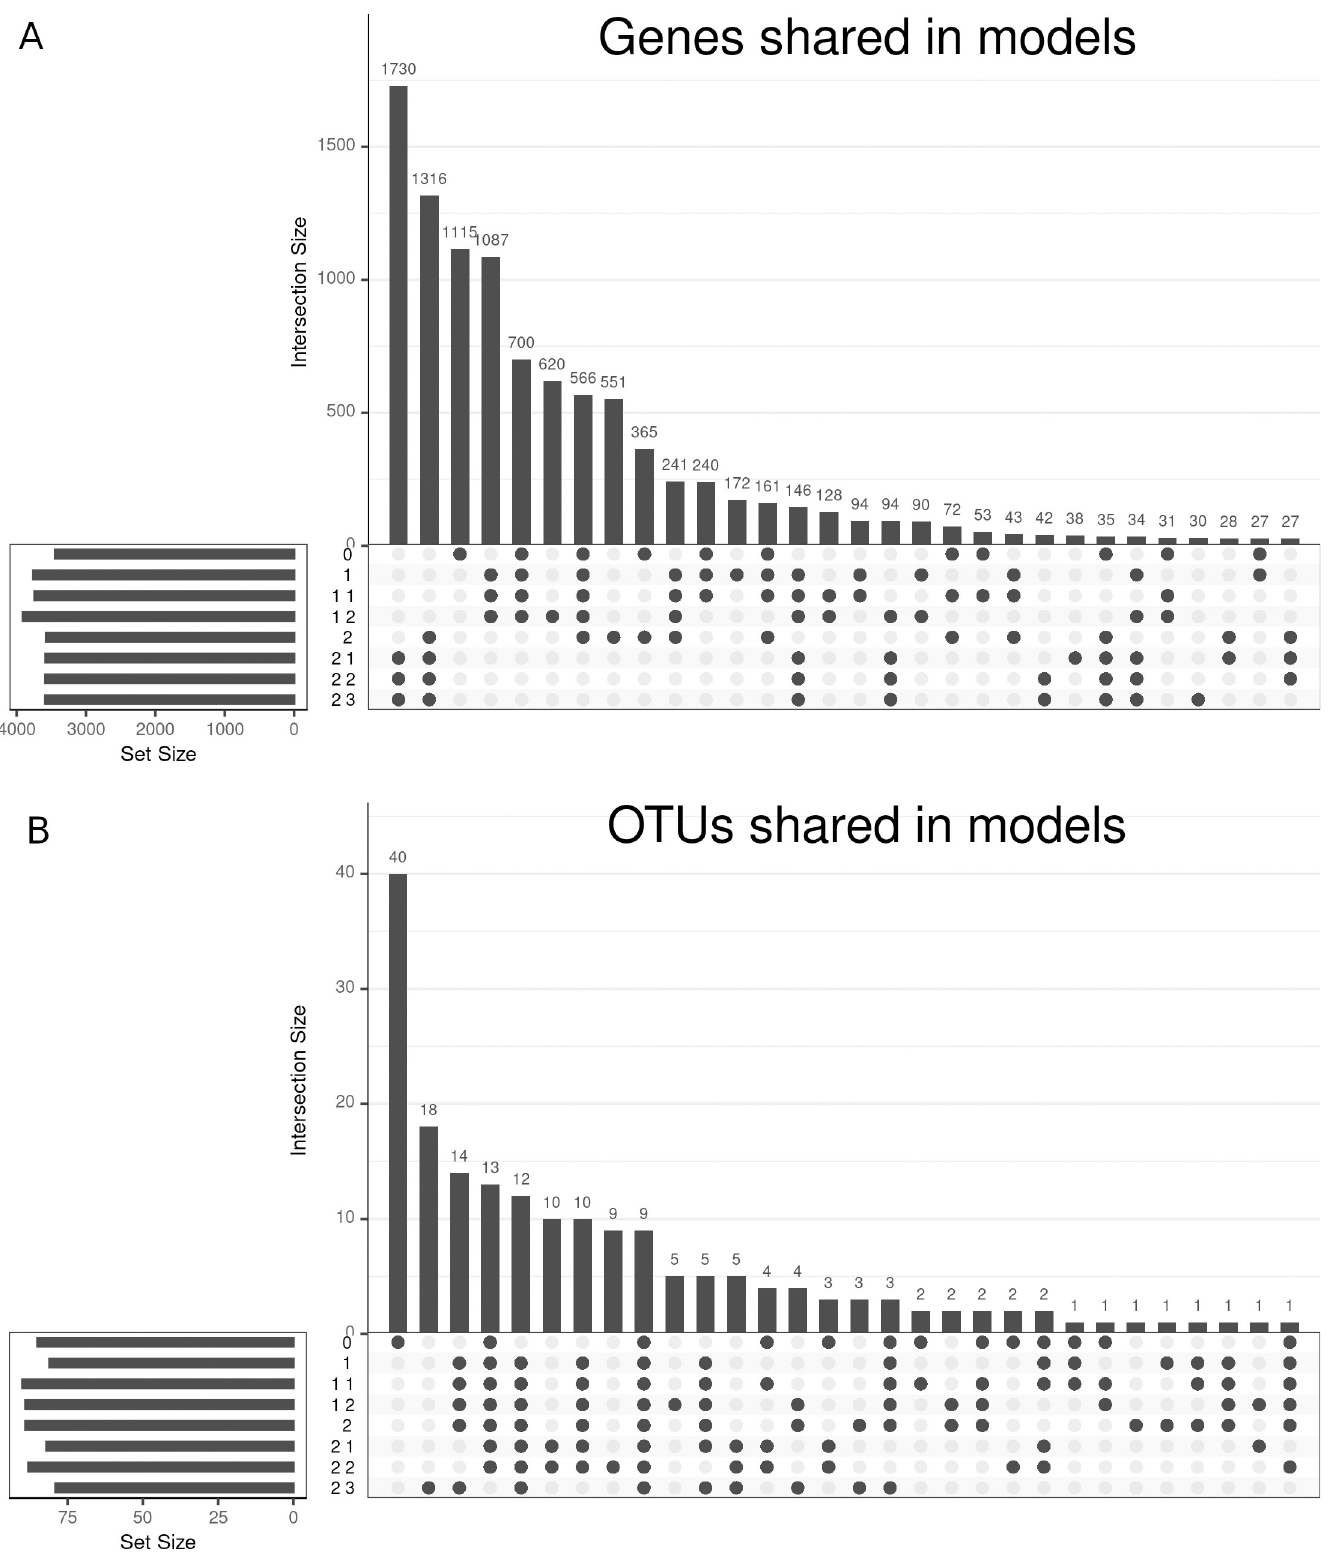
Fig 5. UpSet plot of the of the models on the hematopoietic stem cell transplant Crohn’s disease dataset. The heights of the bars represent the genes (A) or OTUs (B) shared between the models selected by the points; 30 intersections are shown. https://doi.org/10.1371/journal.pone.0246367.g005 PLOS ONE | https://doi.org/10.1371/journal.pone.0246367 February 8,